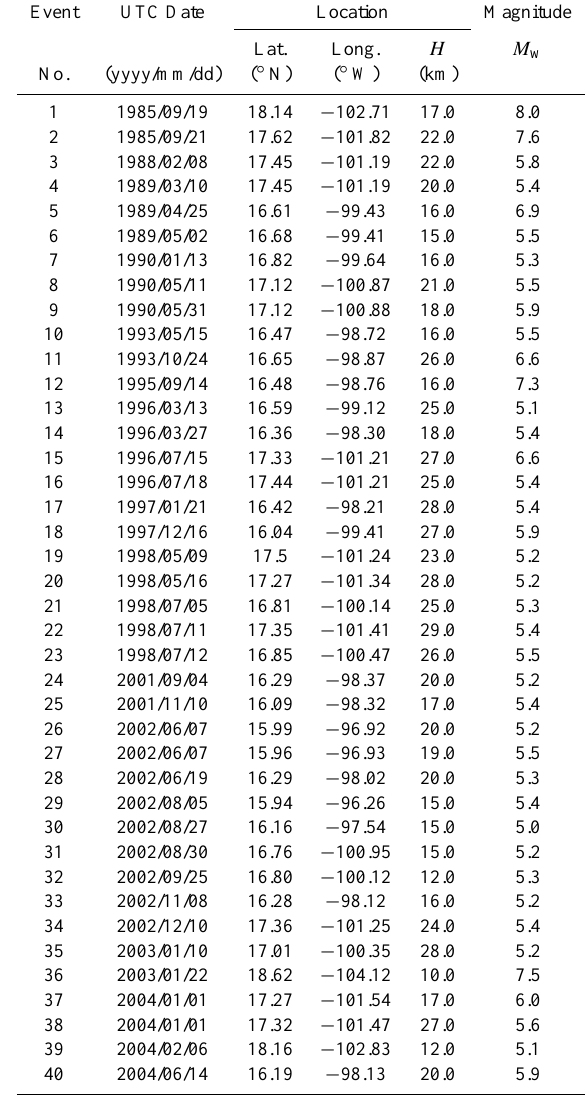
Table 7a. Relevant events in the Subduction zone region (SUB2 and